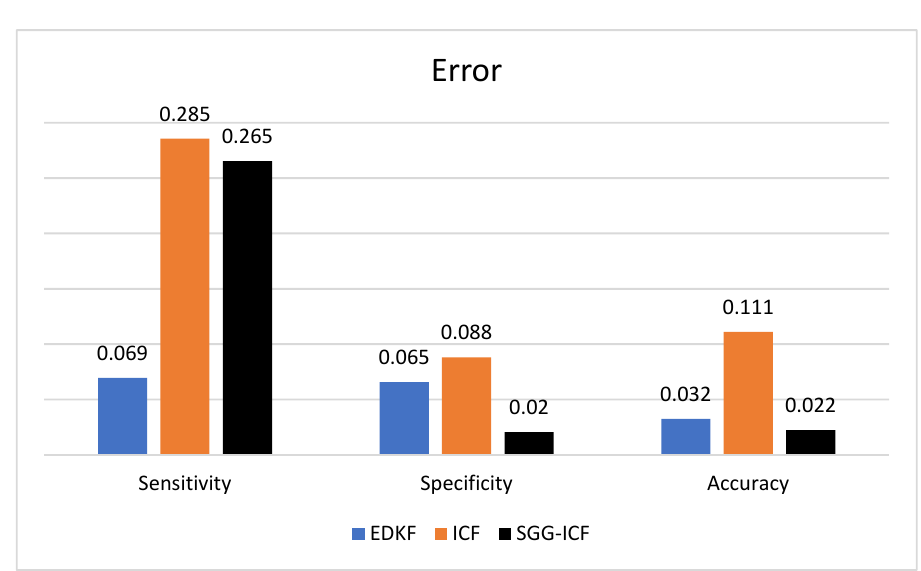
Figure 13. Error categorized by performance metric.